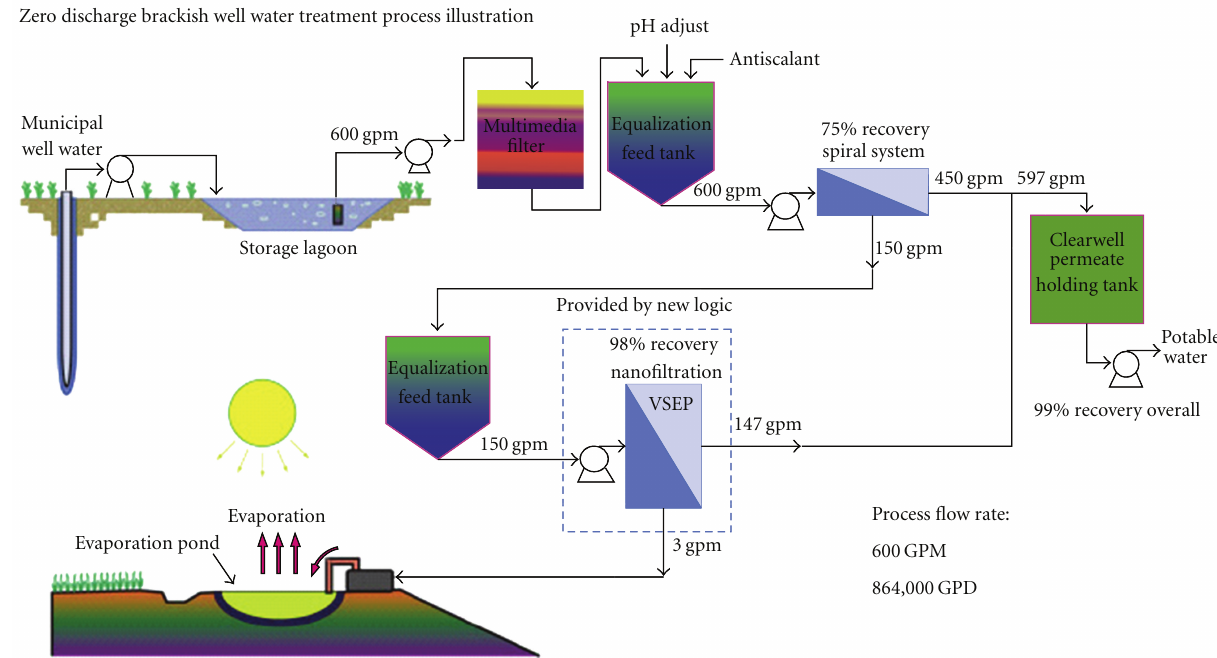
Figure 3: VSEP process schematic for pilot tested RO reject application [8].